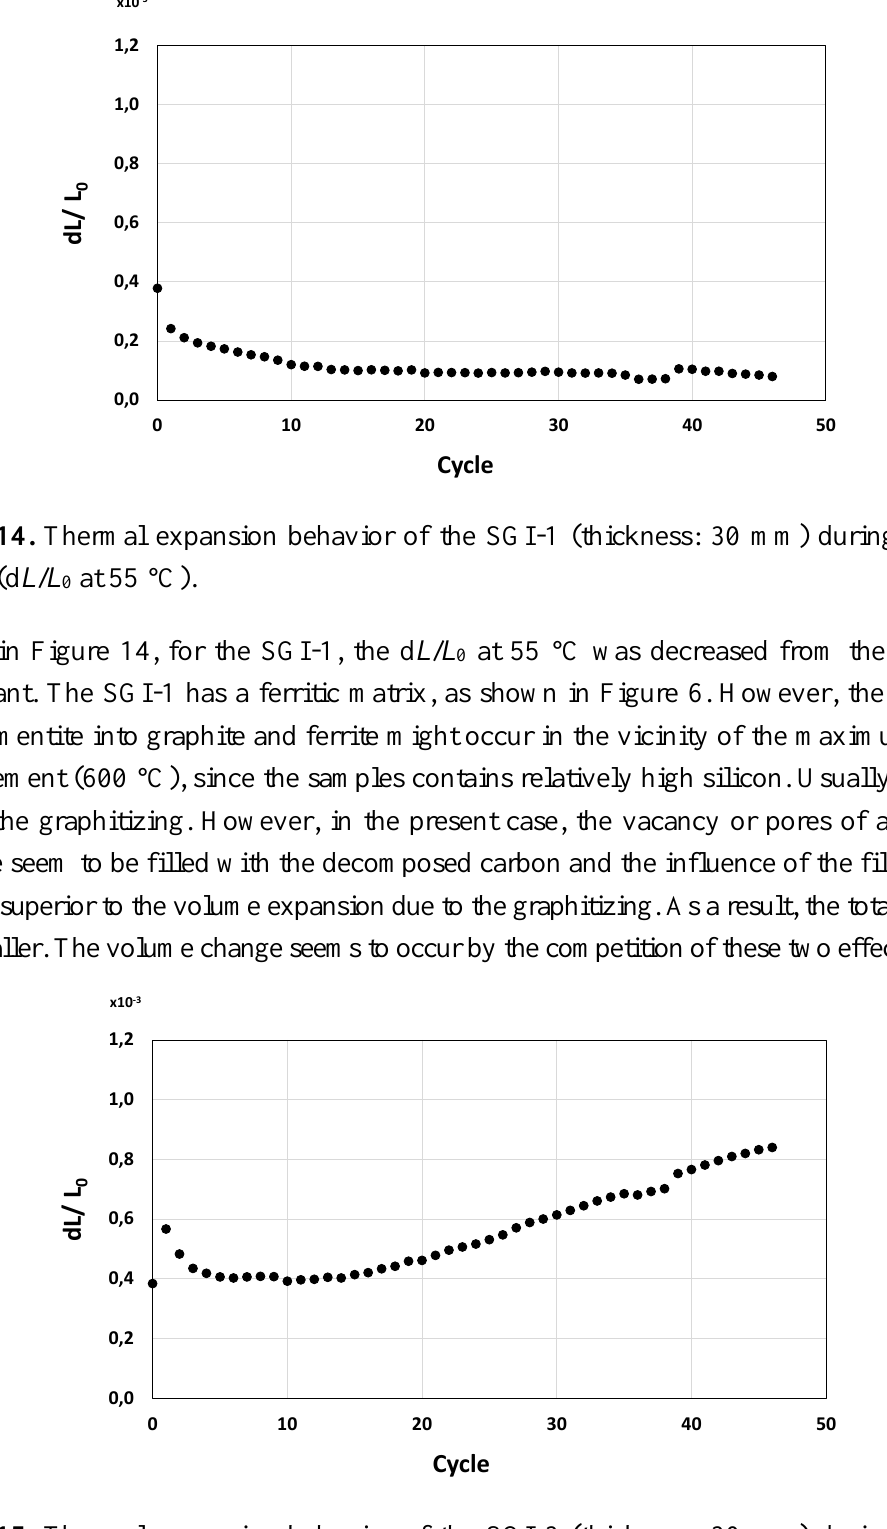
Figure 15. Thermal expansion behavior of the SGI-3 (thickness: 30 mm) during thermal cycling (d L / L 0 at 55